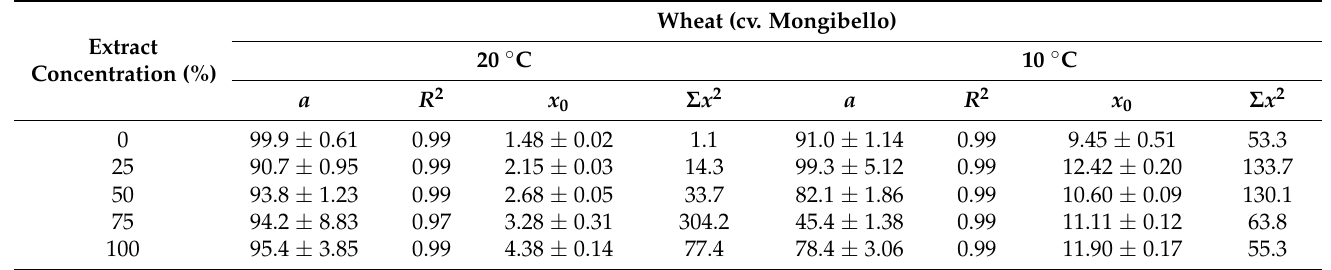
Figure 1. Time course (solid curves) of cumulative seed germination at different hemp leaf extract concentrations of the imbibition solution at 20 and 10 °C, in wheat cv. Mongibello and barley cv. Alamo. Symbols represent the observed percentage with time. Table 2. Values of parameters of the sigmoidal logistic function interpolating data of seed germination at 20 and 10 °C in wheat cv. Mongibello under different hemp leaf extract concentrations.